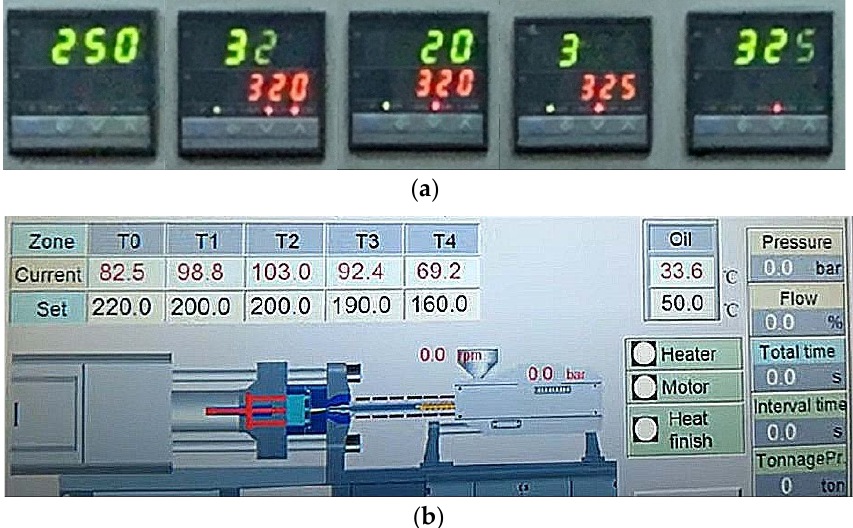
Figure 9. The data on the PLC panel; ( a ) numerical data; ( b ) text and graphical data.